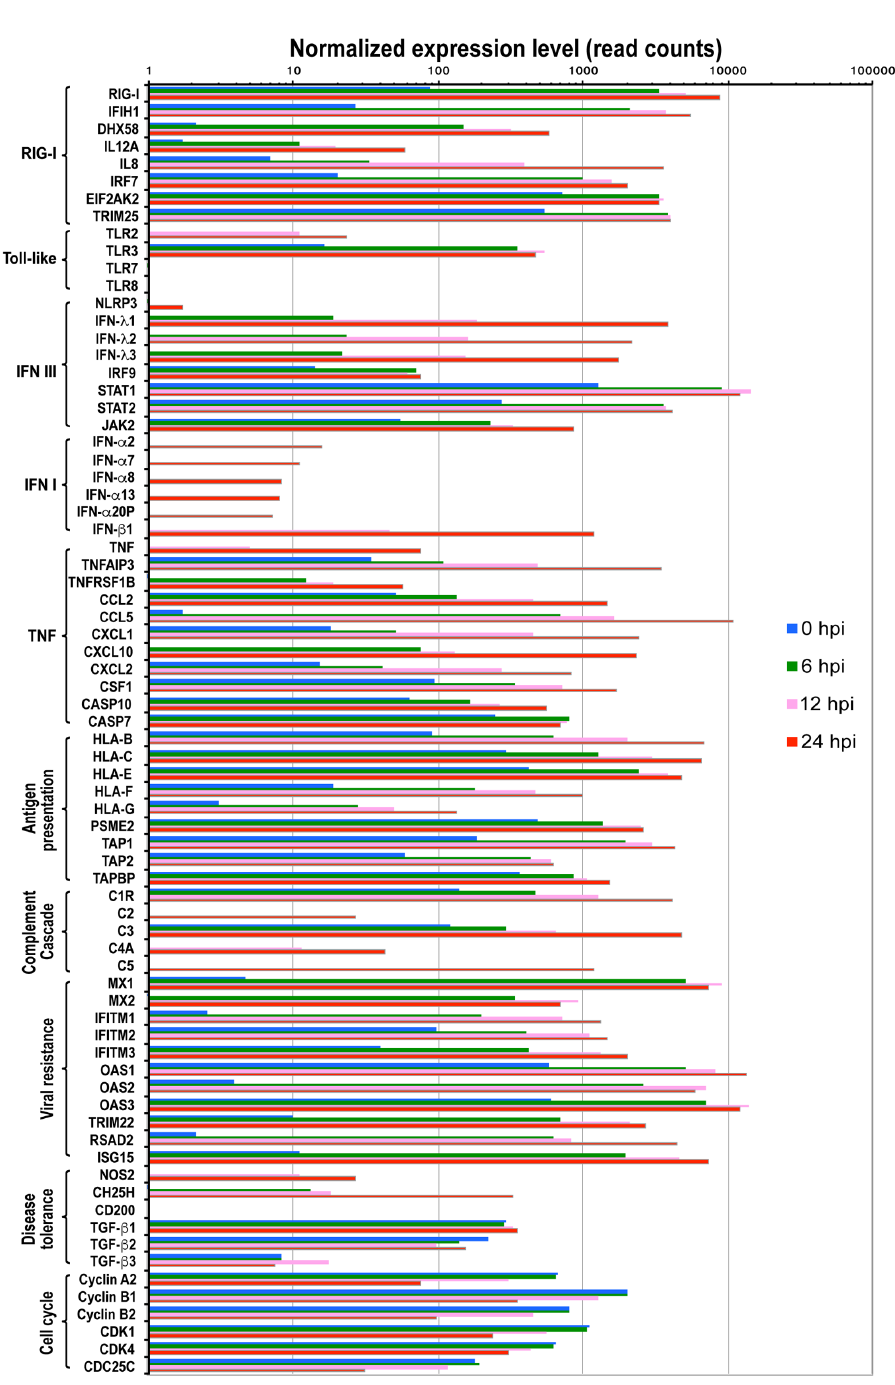
Figure 3. Expression levels of cellular genes in the context of functional category upon IBV infection. The functional categories and included genes with significant expression level changes upon IBV infection are shown below the bar graph. Each bar represents the average reads of 2 repeats for the gene at a time point. The orange, green, blue, and red bars indicate reads of each gene at 0, 6, 12, and 24 hpi, respectively. Di ff erential expression statistical analysis was conducted using DESeq.